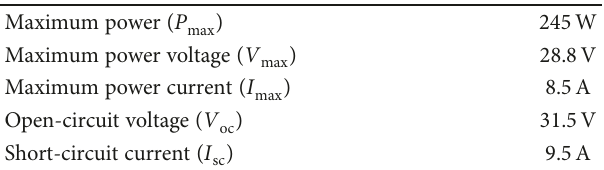
Table 2: The PV module